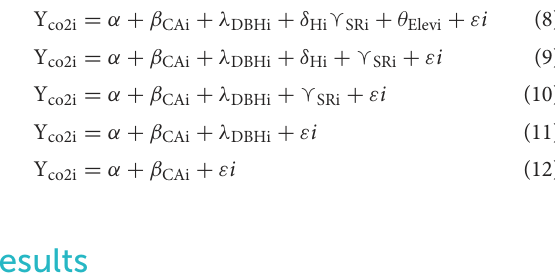
model into six parts to find the direct, indirect, and total effects and measure all the below equations